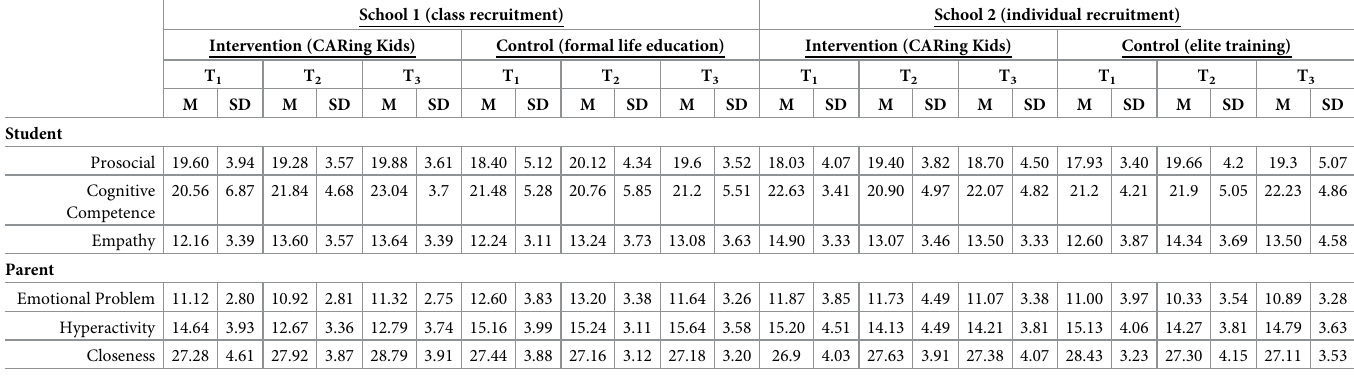
Table 2. The mean scores of social–emotional competences of participants at three time